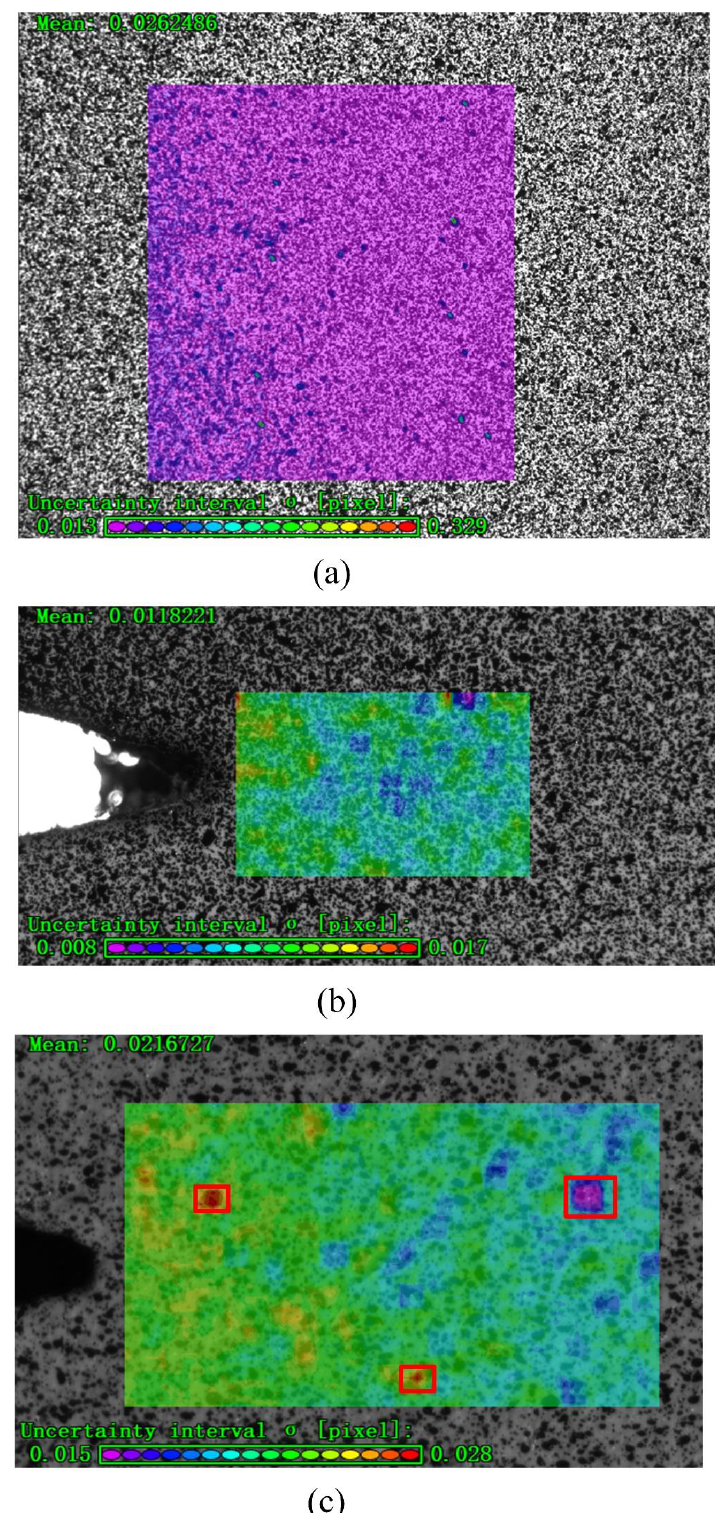
Figure 5. Confidence assessment: ( a ) the confidence of ROI in macroscopic speckle image, ( b ) the confidence of ROI in microscopic speckle image, and ( c ) microscopic speckles are